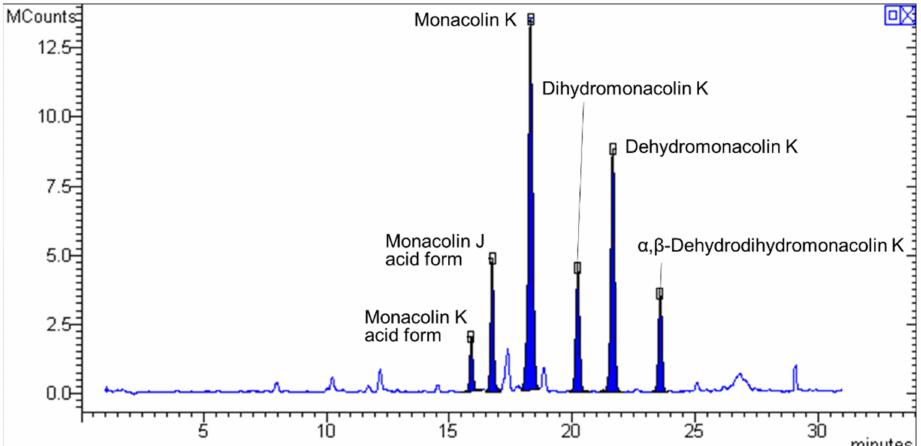
Figure 2. Representative chromatogram obtained from the analysis of a dietary supplement containing red yeast rice. The monacolins indicated in the figure were detected as [M+Na] + adducts ( m/z values for